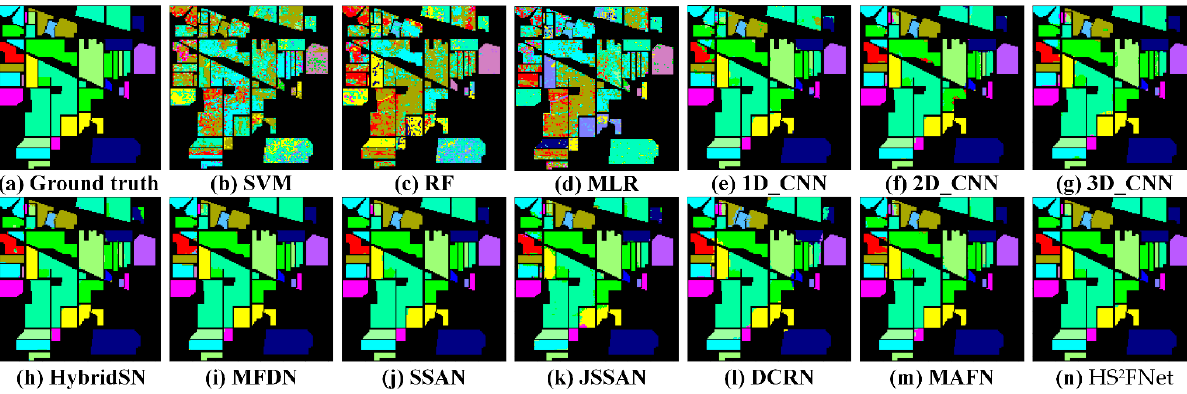
Figure 12. The visual comparisons of the state-of-the-art models and our network on IP dataset.